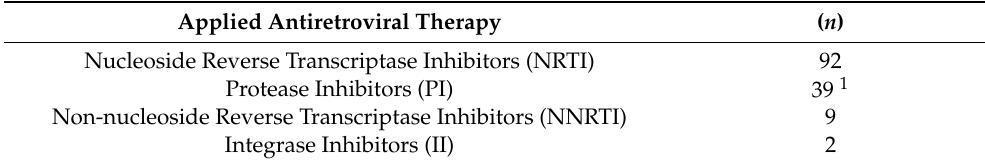
Table 2. Antiretroviral therapy among